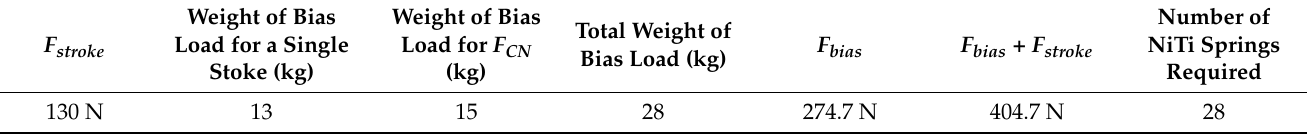
Table 2. Force analysis summary for the solar-driven SMA thermomechanical actuator.